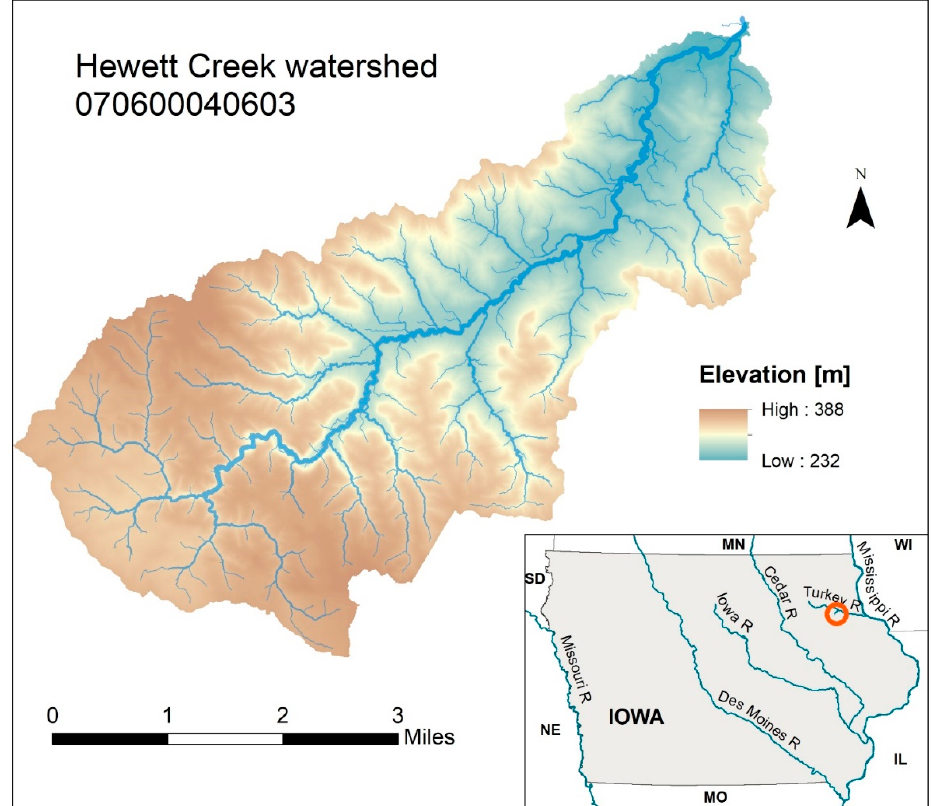
Figure 2. Overview of the study area.